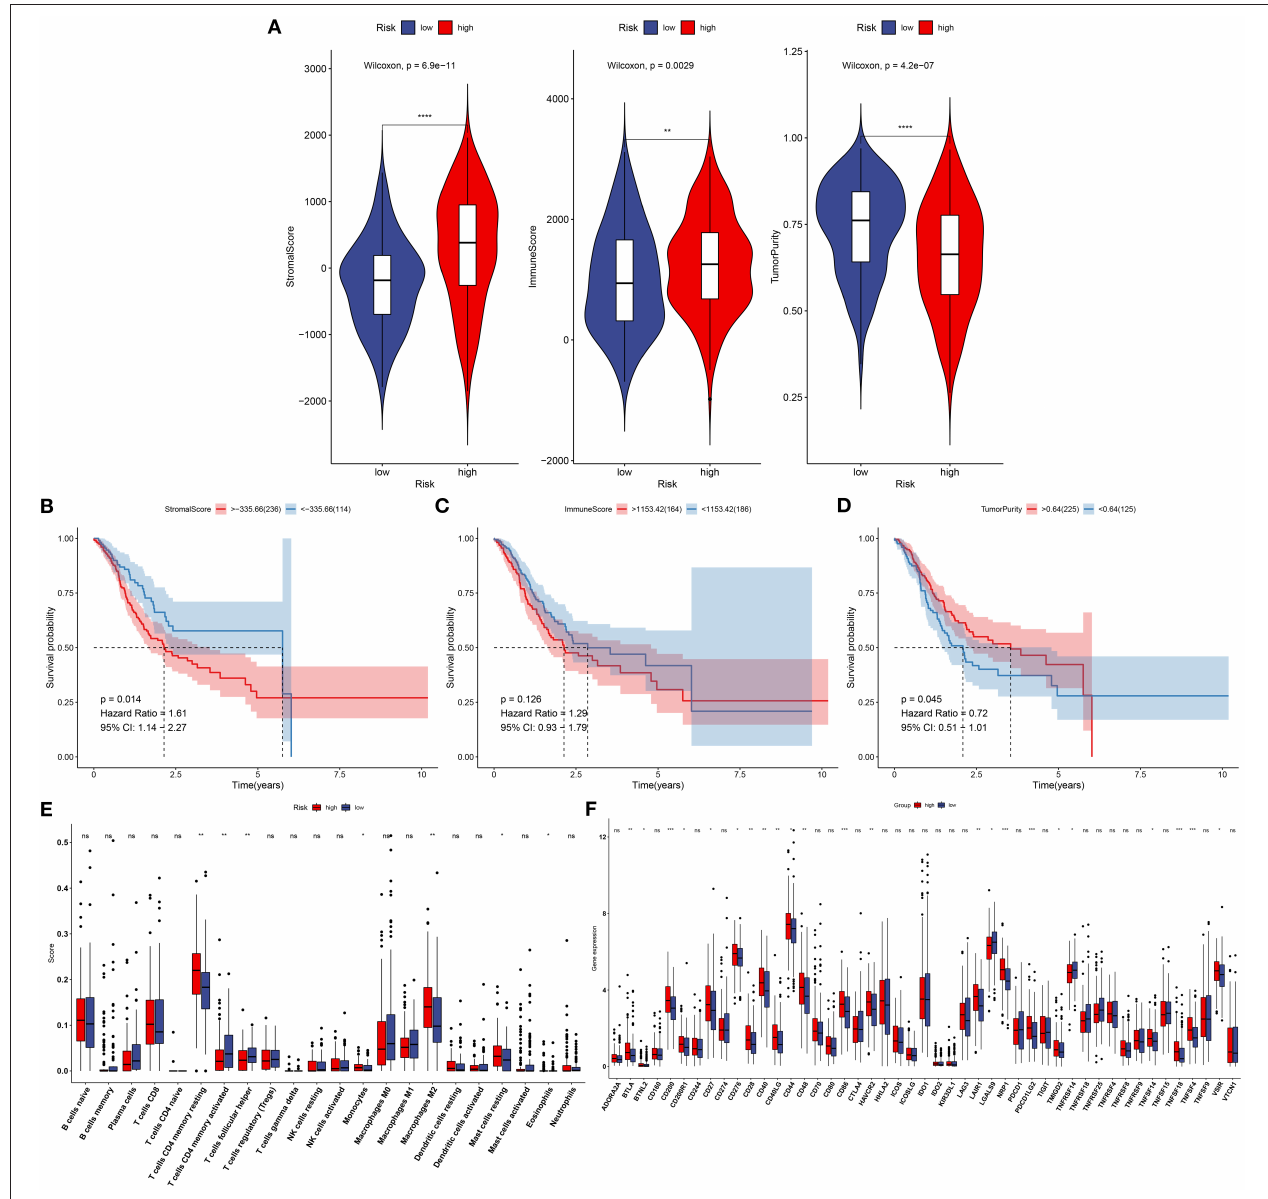
FIGURE 6 | Association between this signature and tumor microenvironment in the training set. (A) Violin plots for stromal score, immune score, and tumor purity of high- and low-risk specimens via the ESTIMATE. (B) Kaplan–Meier curves of high- and low-stromal score groups. (C) Kaplan–Meier curves of high- and low-immune score groups. (D) Kaplan–Meier curves of high- and low-tumor purity groups. (E) Box plots for infiltration levels of immune cells in high- and low-risk samples through the CIBERSORT. (F) Box plots for expression of immune checkpoints in high- and low-risk samples. Ns, not significant. * p < 0.05; ** p < 0.01; *** p < 0.001; **** p <